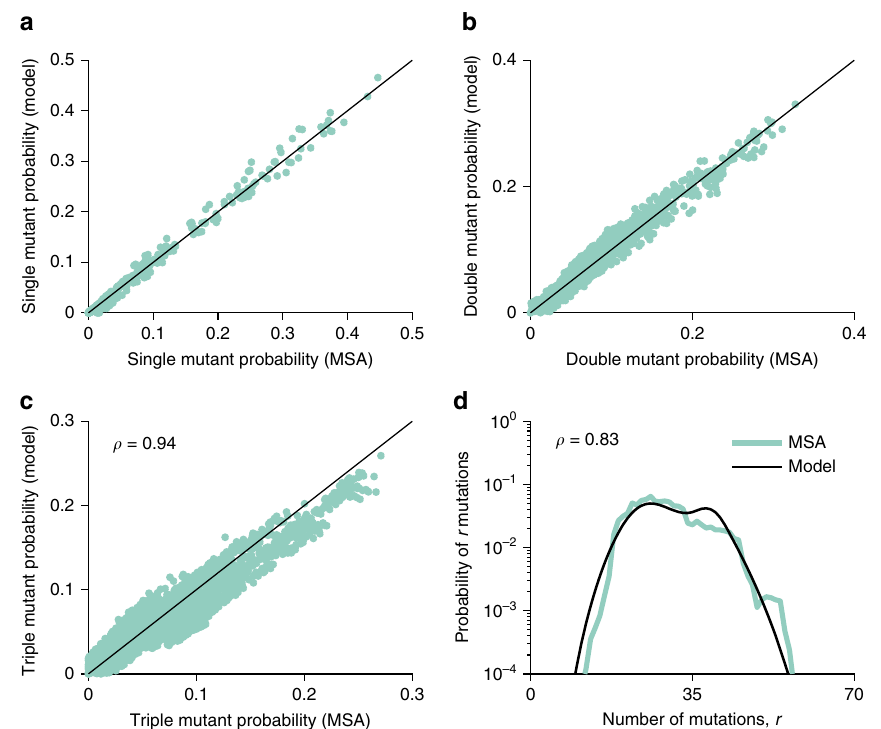
Fig. 1 Statistical validation of the inferred E2 landscape. The inferred model accurately reproduces the statistics of the observed E2 sequences. Scatter plots of the data statistics, single mutant ( a ) and double mutant probabilities ( b ), used to train the model. Results for the data statistics, the triple mutant probabilities ( c ) and the distribution of the number of mutations ( d ), predicted by the inferred model. A strong Pearson correlation of ρ ¼ 0 : 94 and ρ ¼ 0 : 83 is observed between the MSA and model probabilities,